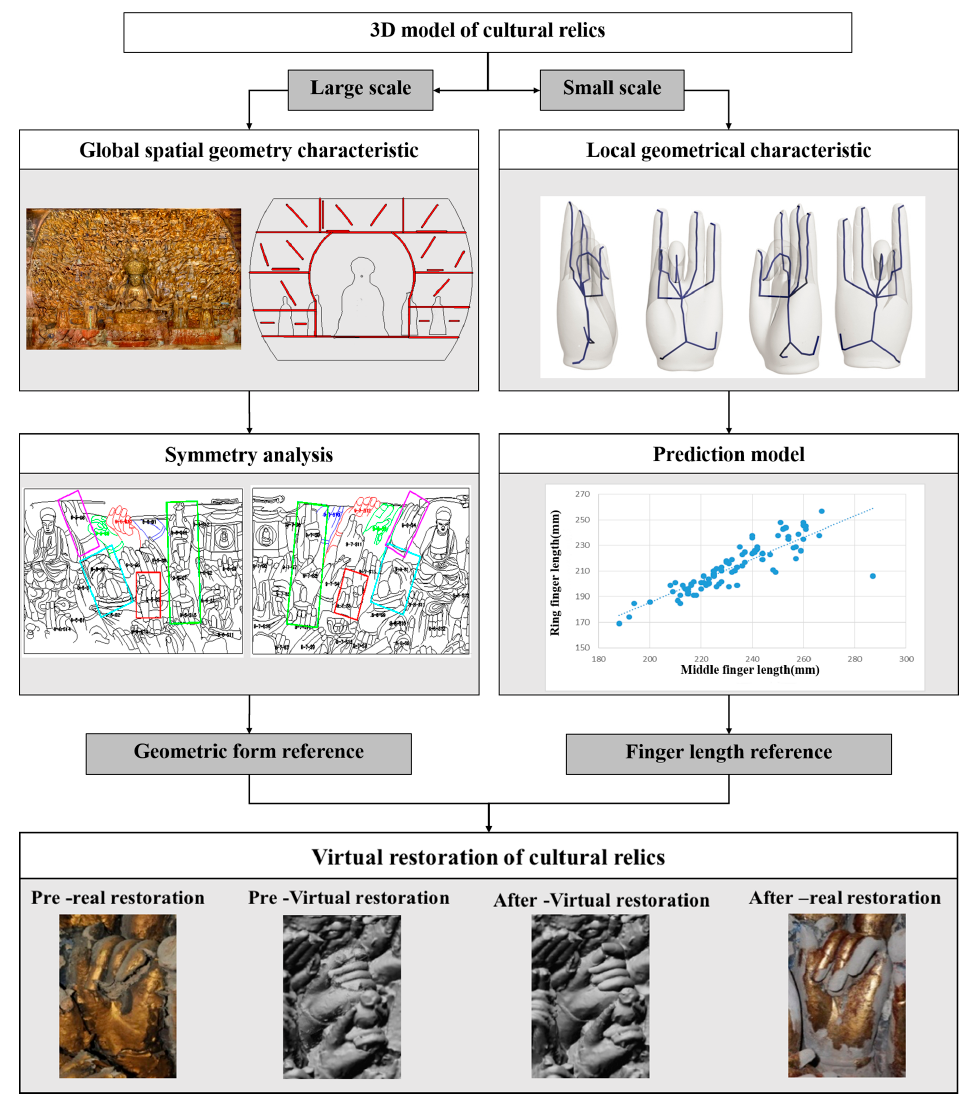
Figure 2. Overall technical process of the proposed method.